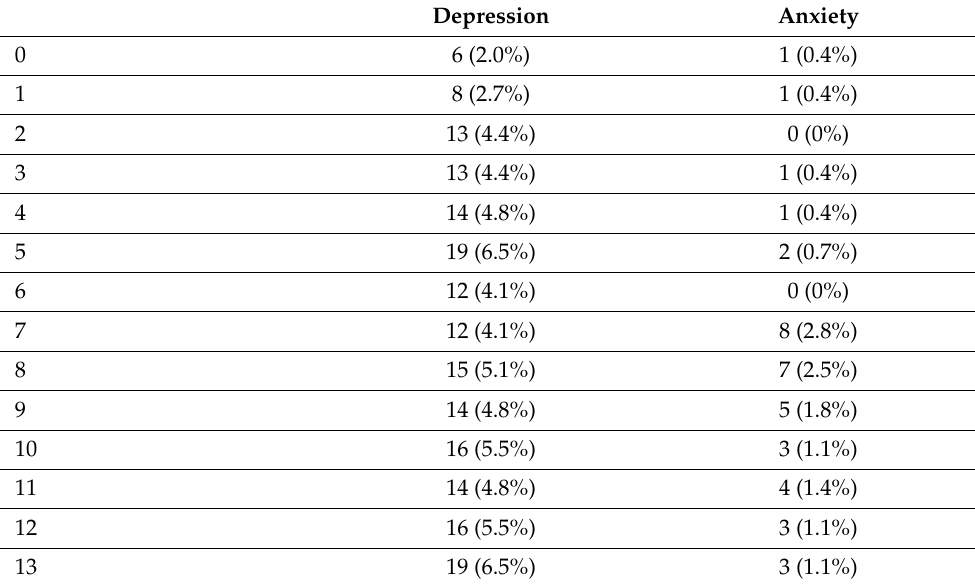
Table 3. Frequency of participants according to the depression and anxiety